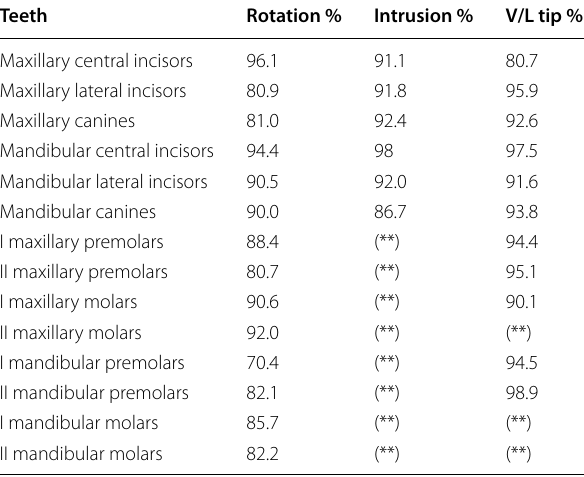
Table 3 Mean accuracy rate for tooth and